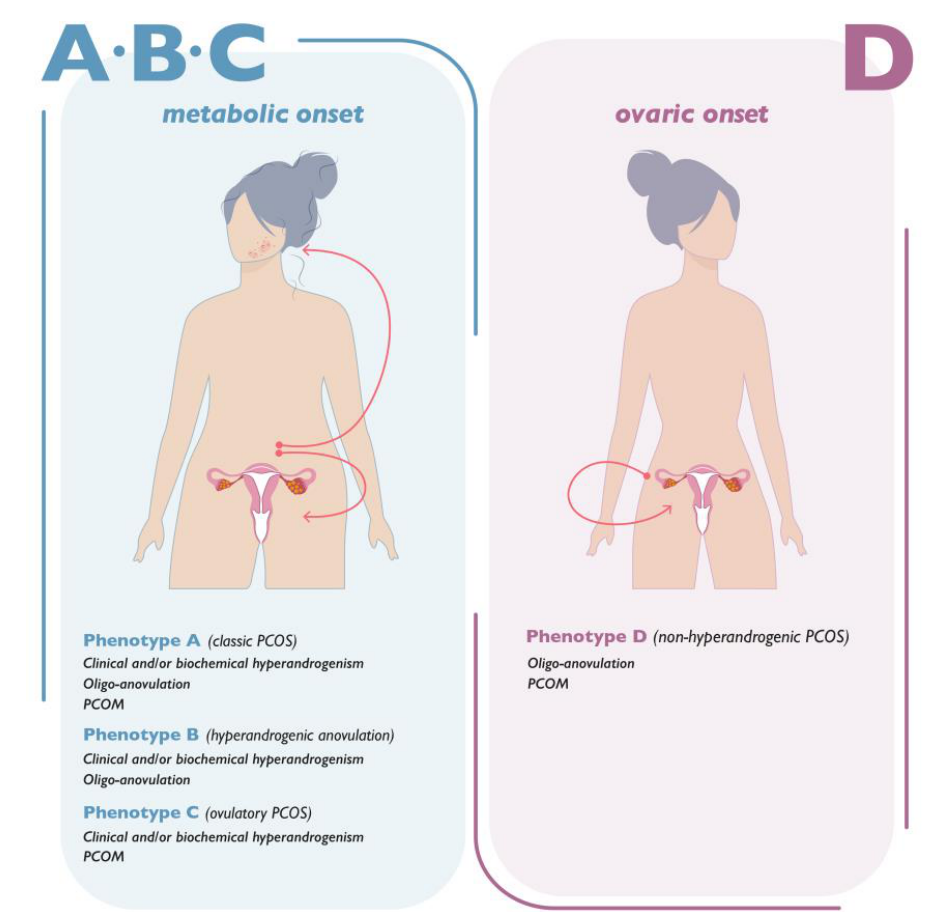
Figure 1. PCOS phenotypes. PCOS (polycystic ovary syndrome) and PCOM (polycystic ovarian morphology). Schematic illustration of the onset of the PCOS condition in the different phenotypes. Phenotypes A, B, and C share the hyperandrogenism condition and a metabolic onset of the syndrome, which leads to the occurrence of the esthetic manifestations of hyperandrogenism (acne, alopecia, hirsutism, and seborrhea), oligo-amenorrhea, and ovarian cysts. Phenotype D exhibits an ovarian onset of the condition, which directly causes an alteration in the menstrual cycle and the formation of ovarian cysts.